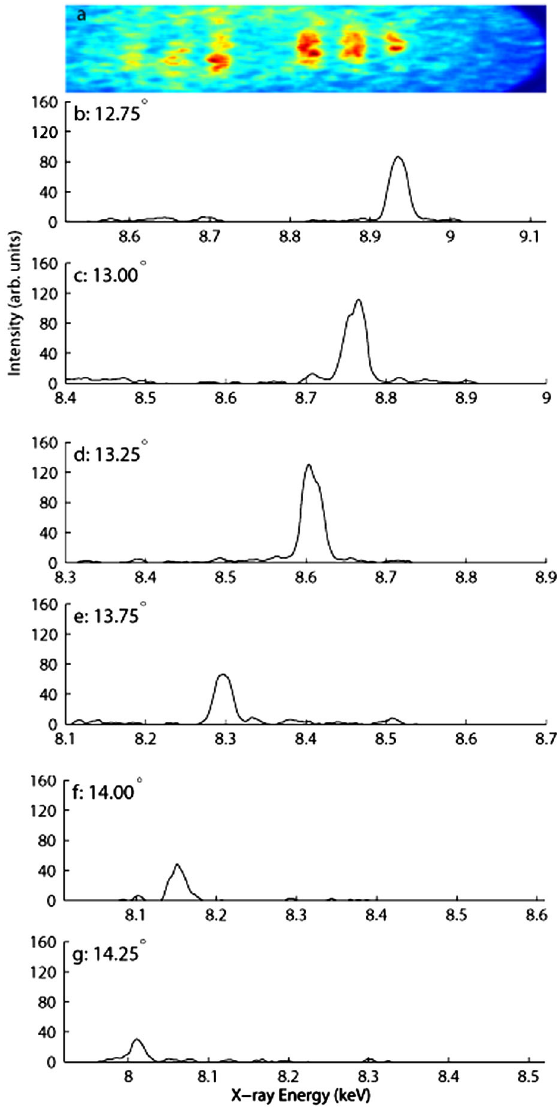
FIG. 4. (a) False color addition of 37 images taken at multiple angles and median filtered showing the physical relationship between the diffraction patterns at each angle ( ’ ) setting. The round edge of the MCP can be seen in the corners. The image is 10 mrad tall. The vertical stripe pattern is due to the rotation of the silicon crystal (see Fig. 1). (b)–(g) Integrated lineouts from each angle ( ’ ) as noted. The integrated area is 2 mrad vertically, centered on the pair of peaks seen in the 12.75 (cid:3) diffraction pattern. Each angle lineout plot is the sum of 4–7 images which has been median filtered. The vertical scales of the images (b)–(g) are the same, while the range of abscissa has been changed to align the peaks to the distributions in